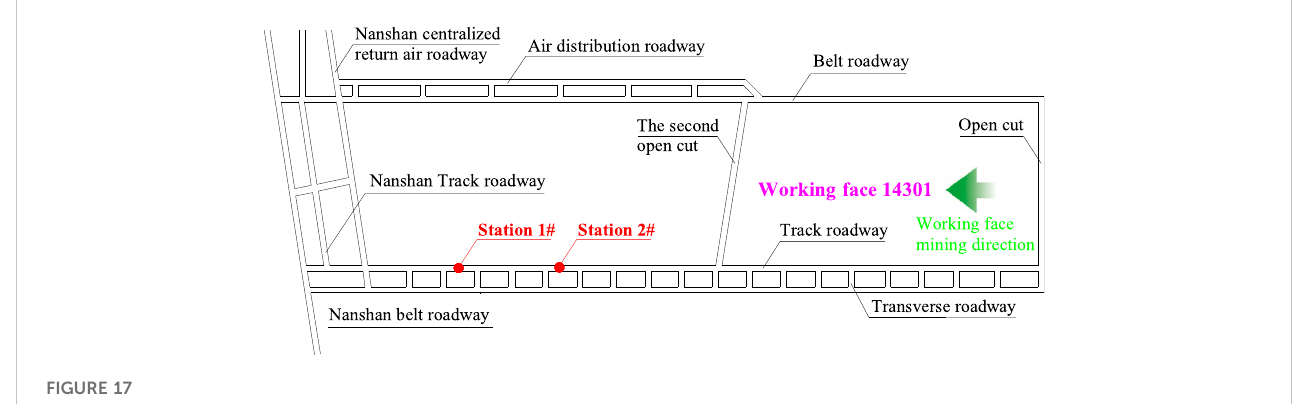
FIGURE 17 Layout of the 14,301 working